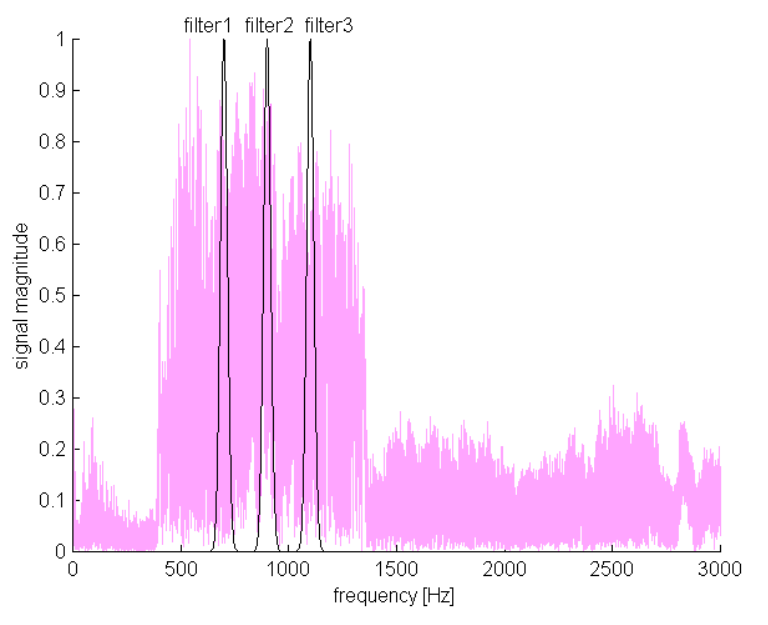
Figure 4. Frequency response of the three-element filter